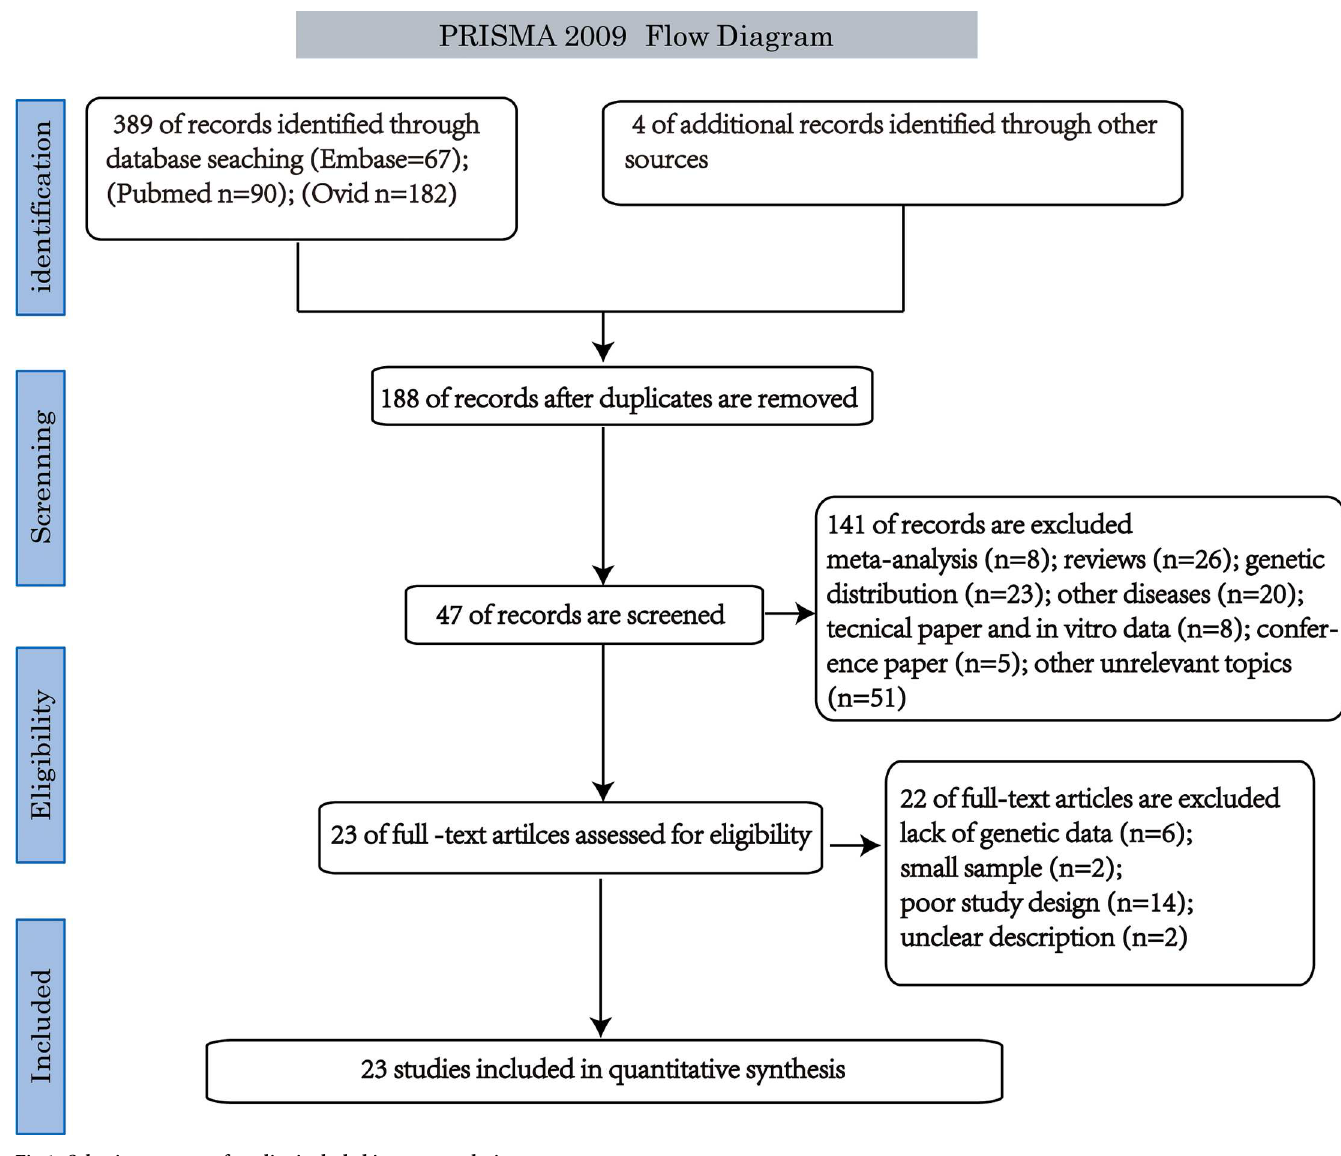
Fig 1. Selection process of studies included in meta-analysis.